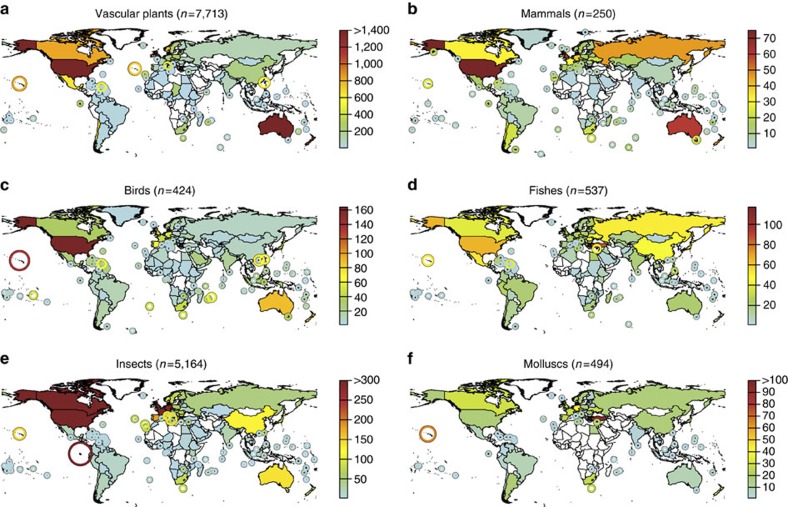
Number of first records of established alien species per region (mainlands and islands) for major taxonomic groups.(a–f) Colour and size of circles indicate the number of first records of established alien species. Circles denote first records on small islands and archipelagos otherwise not visible. The world maps were created using the ‘maptools' package40 of the open source software R36.